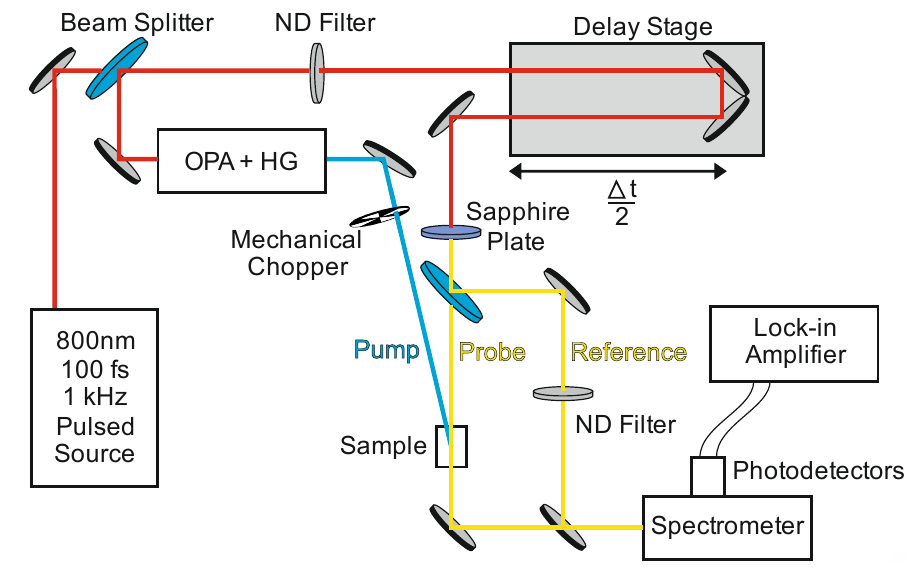
Figure 2. Schematic of a typical ultrafast transient absorption (UTA) experiment for measuring MEG. A Ti:Sapphire regenerative amplifier seeded by a Ti:Sapphire oscillator produces a pulsed beam at 800 nm, with 100 fs pulse width, ~1 mJ pulse energy and 1 kHz repetition rate (red line). Using a beam splitter 95% of this beam is passed to an optical parametric amplifier (OPA) with harmonic generating (HG) crystals to produce a pump beam that is tunable from the infra-red to the ultra-violet (blue line). The pump beam is passed through a mechanical chopper to improve the signal-to-noise ratio and then focused onto the sample. The remaining 5% of the beam from the amplifier is directed through a delay stage to vary the arrival time difference between pump and probe pulses at the sample. This beam is then passed through a sapphire plate to produce a white light continuum, which is split to form the probe and reference beams (yellow line). After the sample, the probe and reference beams are balanced using a neutral density (ND) filter (in the absence of the pump), passed through a spectrometer, then onto separate photodetectors. Small differences in probe and reference are detected using a lock-in amplifier synchronised to the